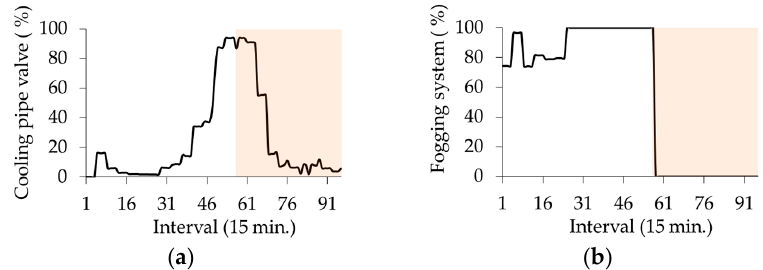
Figure 13. Equipment usage for environment control in a building microgrid with rooftop greenhouse: